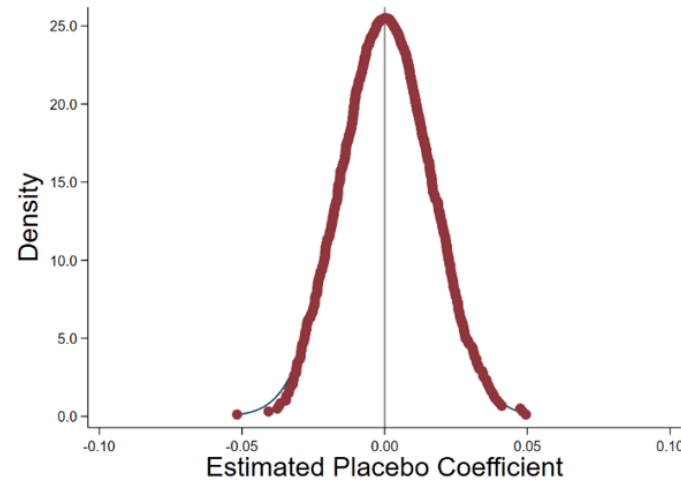
Figure 3. Distribution of placebo estimates. Table 7. The results after deleting the current year of the list